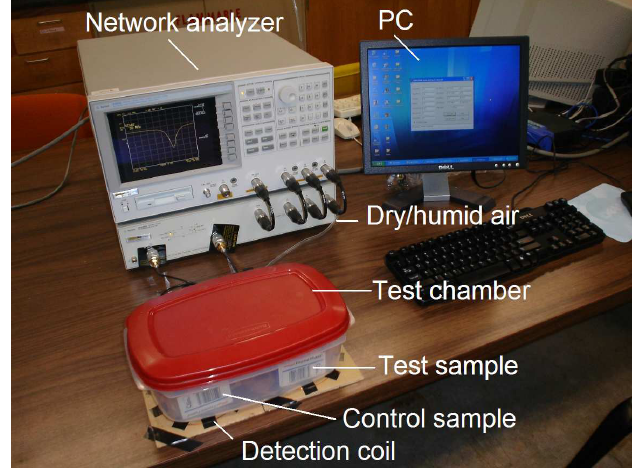
Figure 7. Photograph of the experimental setup for demonstrating the application of the LC sensor for real-time food quality